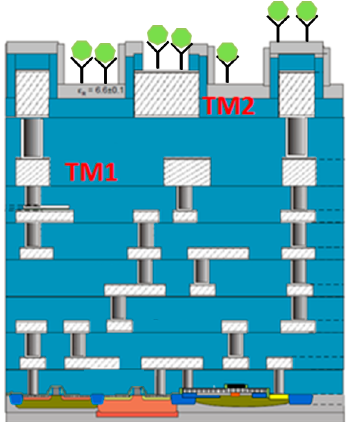
Figure 7. A typical bipolar complementary metal oxide semiconductor (BiCMOS)/complementary metal oxide semiconductor (CMOS) back-end-of-line stack. The top metal layer is used for biomolecule